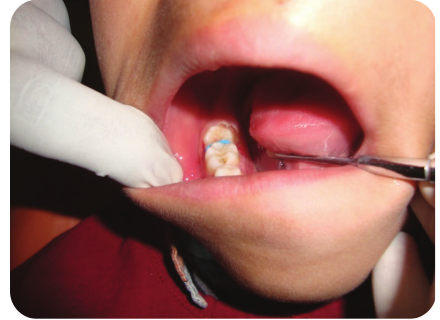
Figure 4: Elastic separator placed